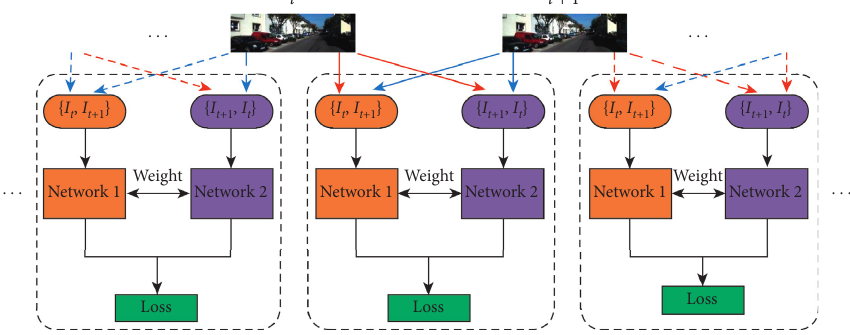
Figure 1: Architecture of the end-to-end DSCNN-based monocular